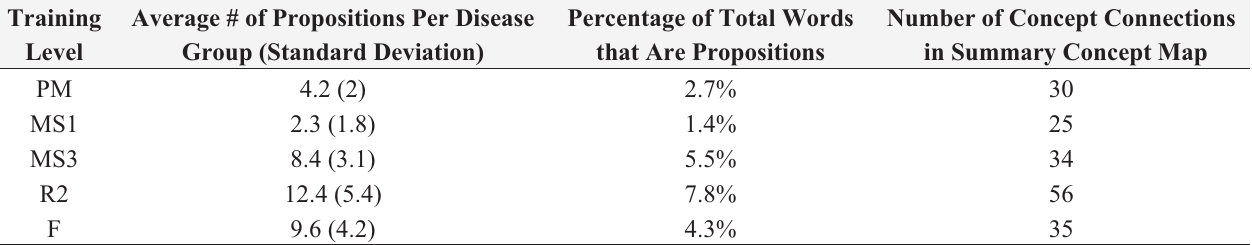
Table 1. Average numbe of propositions per disease group and number of concept connections in concept maps by training